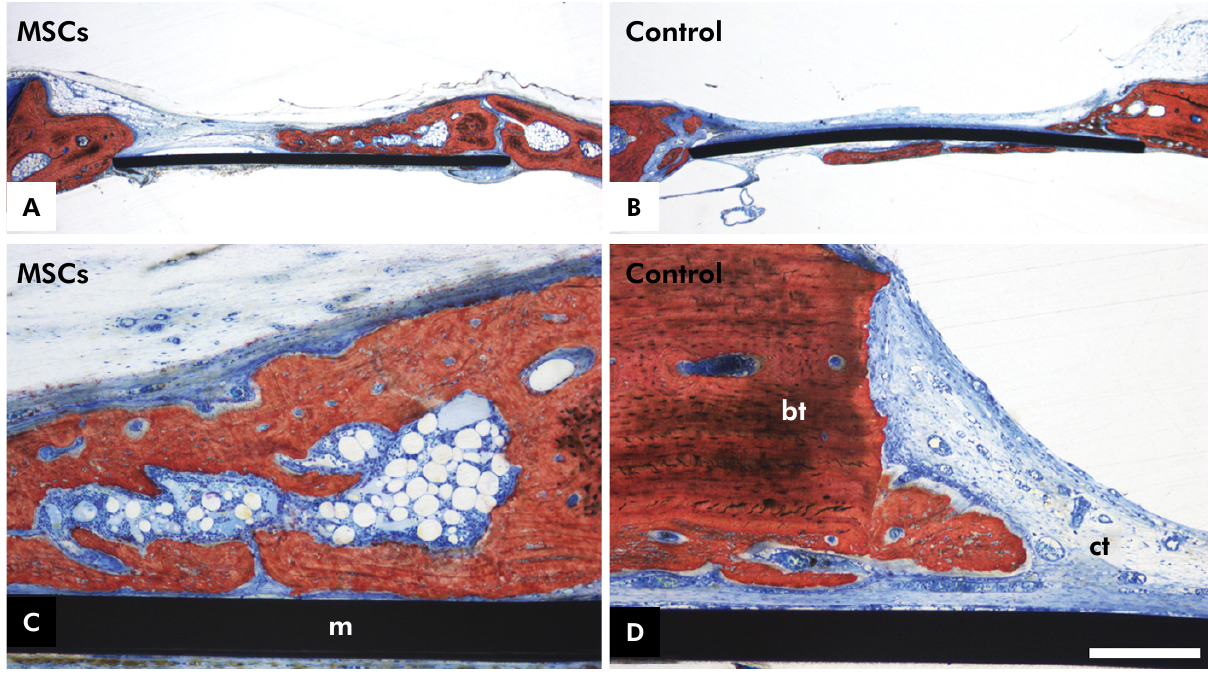
Figure 4. Light microscopy of rat calvarial bone defects implanted with PVDF-TrFE/BT membrane and injected with MSCs or PBS (Control), 4 weeks post-injection. Defects injected with MSCs (A and C) exhibited greater bone formation than defects injected with PBS (B and D), and a significant area of the defects injected with PBS (B and D) was filled with connective tissue. Alizarin red and Stevenel’s blue stain. bt: bone tissue; ct: connective tissue; m: PVDF-TrFE/BT membrane. Scale bar: A–B = 800 μm; C–D = 200